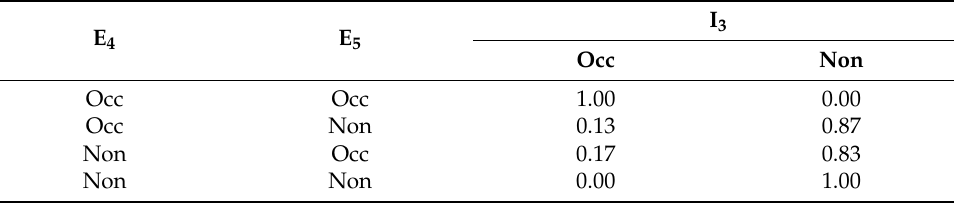
Table A2. The CPT of event I 3 (Abnormal temperature; Occ: occurred; Non: